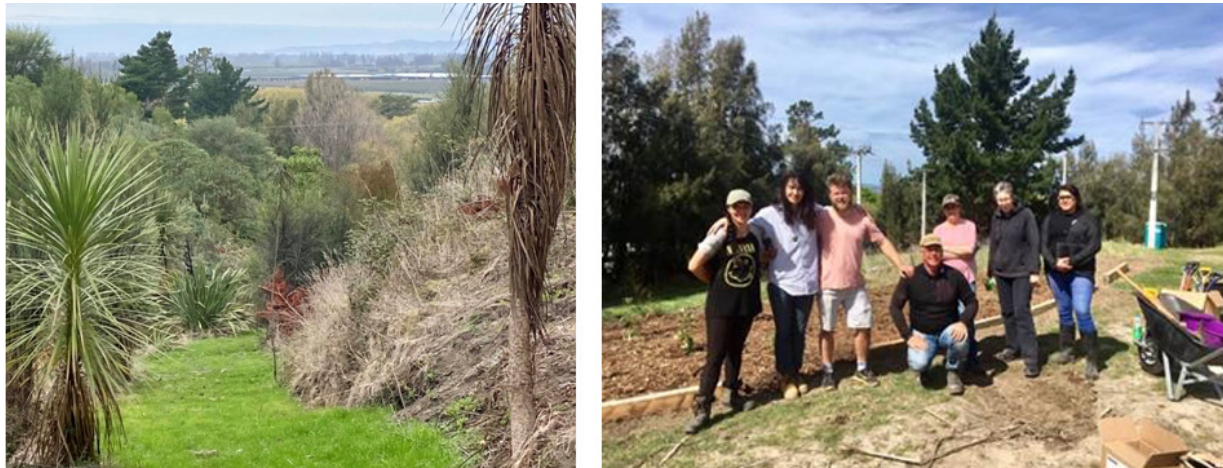
Figure 7. A new network of recreational paths at Ōtātara (left) and a group of volunteers planting new areas (right).